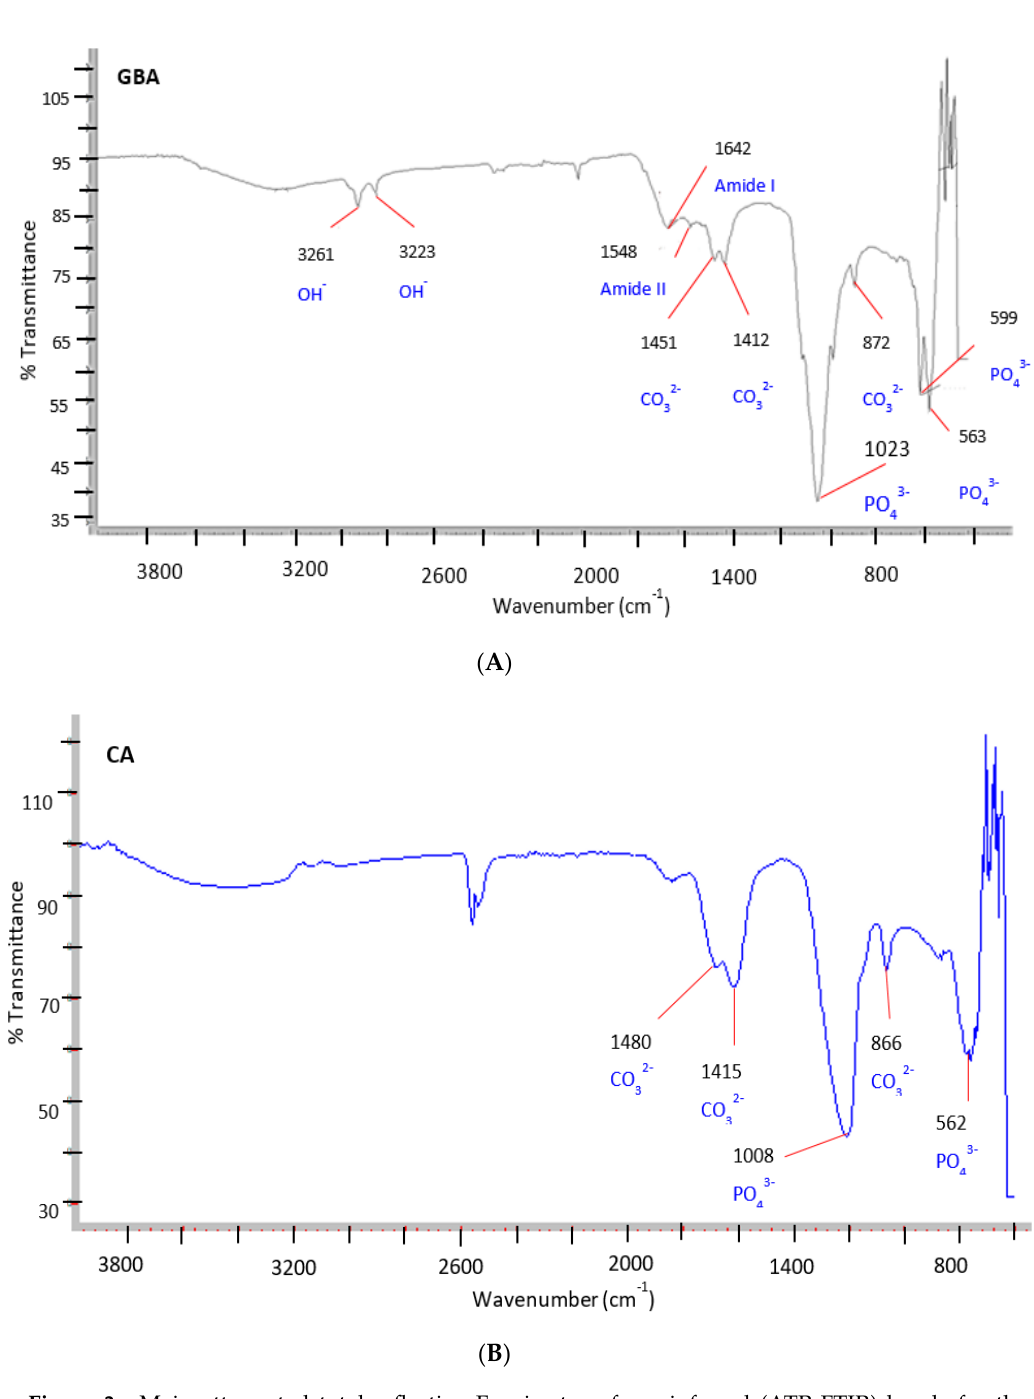
Figure 3. Main attenuated total reflection-Fourier transform infrared (ATR-FTIR) bands for the functional groups in ( A ) pristine GBA powder ( B ) carbonate apatite (CA).